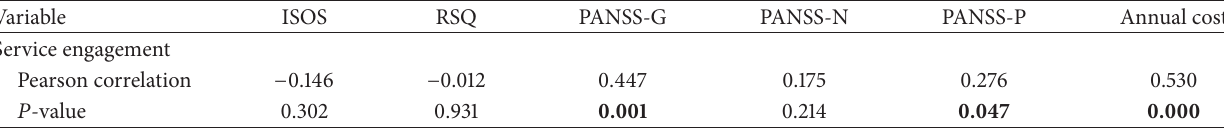
Table 4: Pearson Bivariate correlation between service engagement, PANSS subscales and recovery